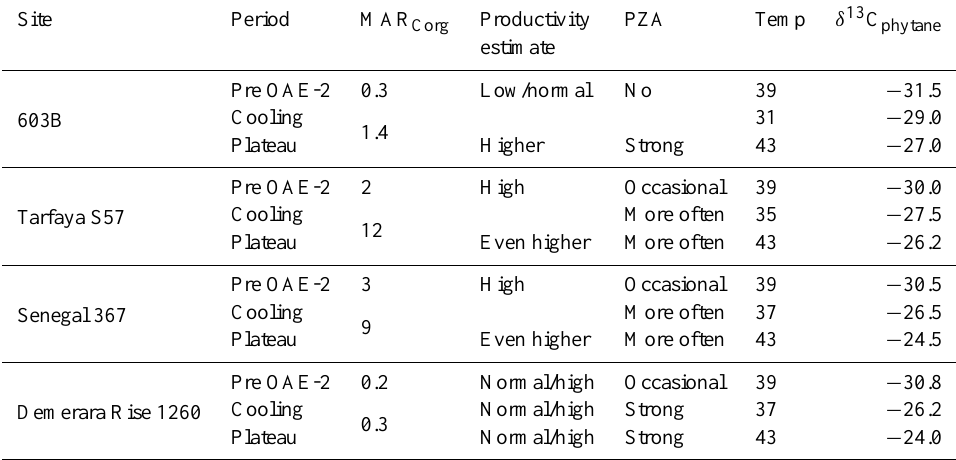
Table 1. Summary of data from the four discussed sites. Productivity estimates based on TOC contents and mass accumulation rates of organic carbon (MAR Corg ) in g m − 2 yr − 1 (Forster et al., 2008; van Bentum et al., 2009) at the different sites. Photic zone anoxia (PZA) based on the occurrence of isorenieratane or its derivatives (Site 1260, this study; Site 367, Kuypers et al., 2002b; Tarfaya, Tsikos et al., 2004; Site 603B, Sinninghe Damst´e et al., 2008). Temperatures are SSTs in ◦ C (based on: Forster et al., 2007; Sinninghe Damst´e et